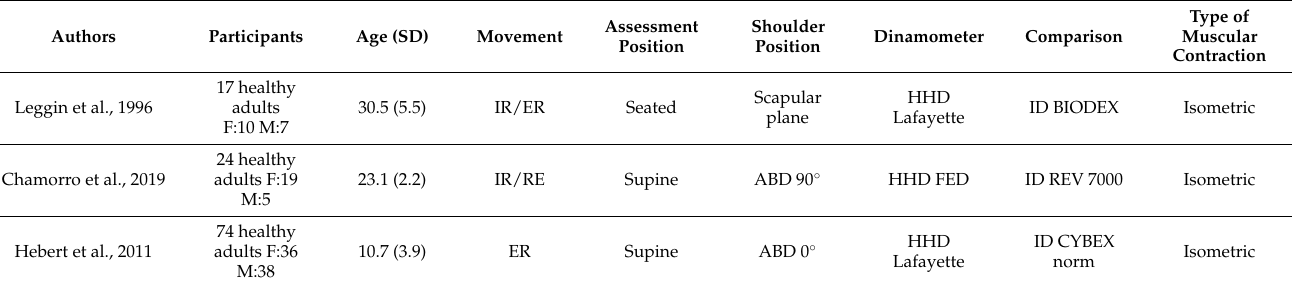
Table 3. Description of studies analyzing concurrent validity between HHD and ID.